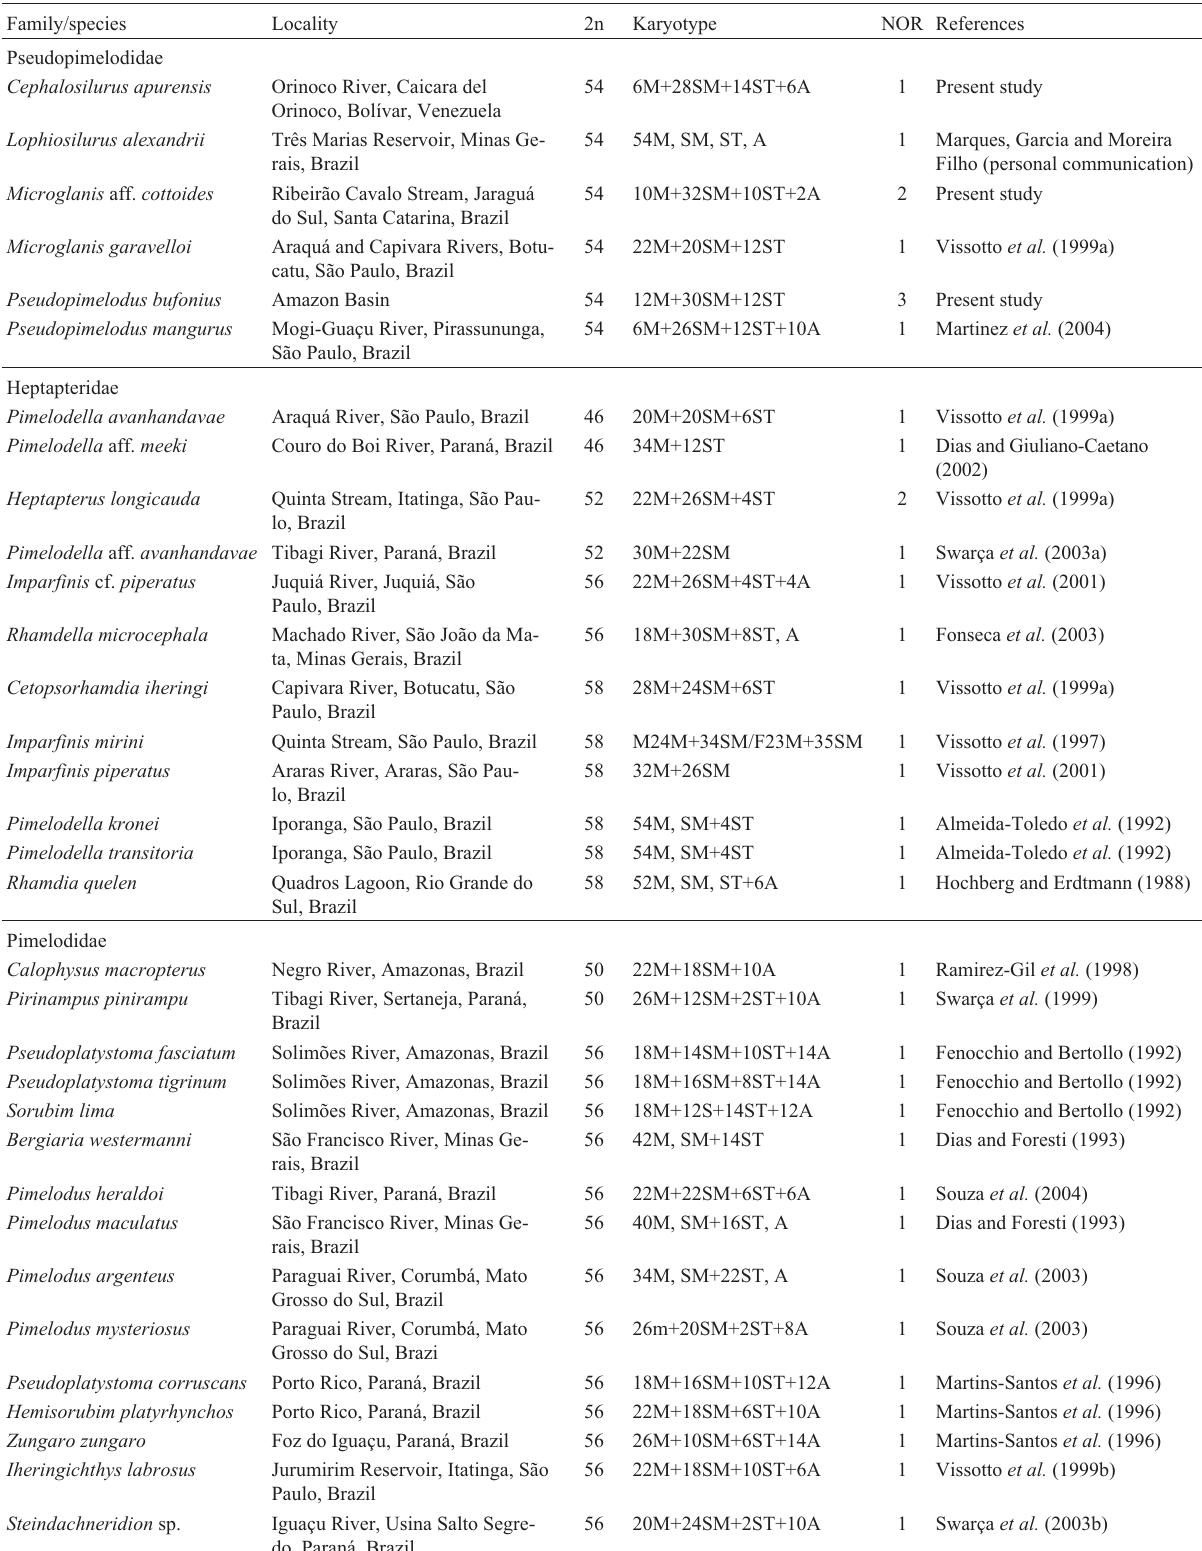
Table 1 - Cytogenetic data for Pseudopimelodidae, Heptapteridae and Pimelodidae.